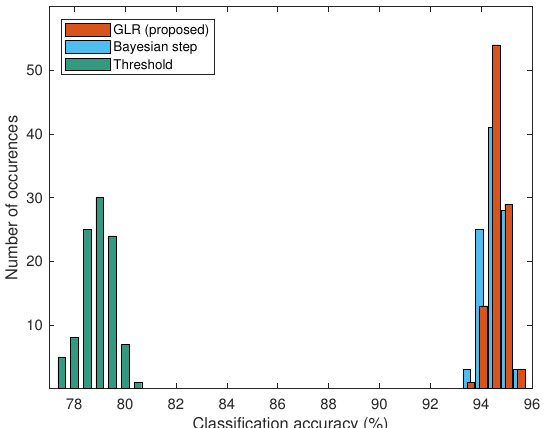
Figure 15. Histogram of classification accuracy at 25 dB SNR.